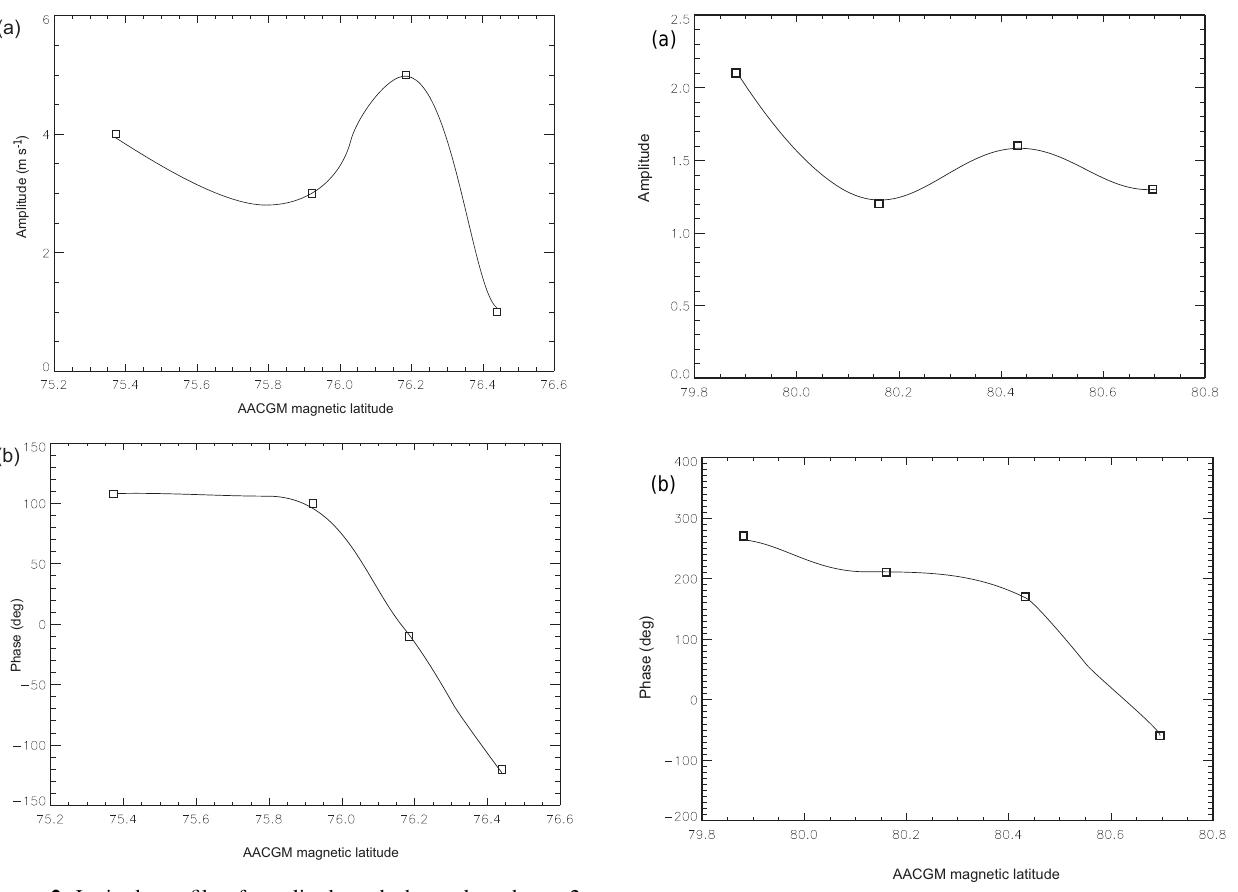
Figure 3. Latitude profile of amplitude and phase along beam 7 (beam aligned closely with the magnetic meridian) of Saskatoon for event